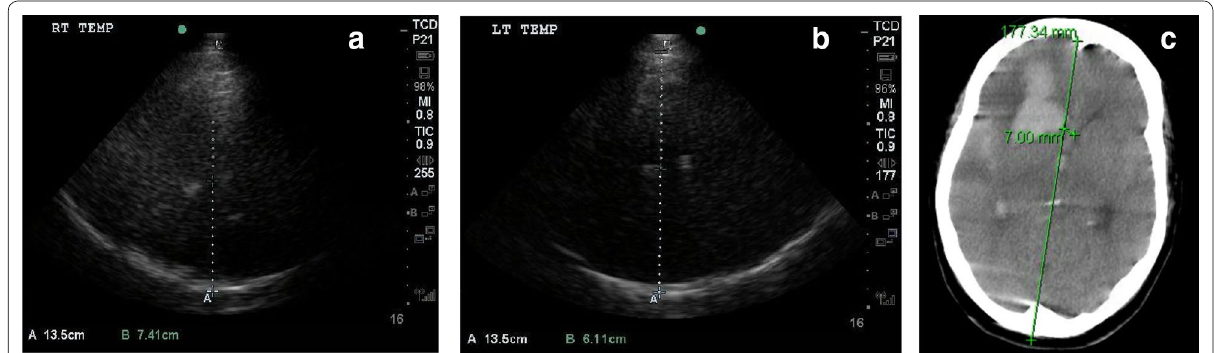
Fig. 1 Transcranial imaging for midline shift. a Insonation from right temporal bone to third ventricle, representing distance A (7.41 cm). b Insona- tion from left temporal bone to third ventricle, representing distance B (6.11 cm). c Follow-up CT scan post TCD which reveals midline shift to be 7